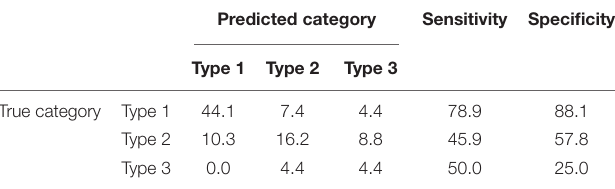
TABLE 5 | Confusion matrix for Suicidal thoughts using the LDA classifier and excluding gender from the inputs (kappa = 38.9%). Predicted